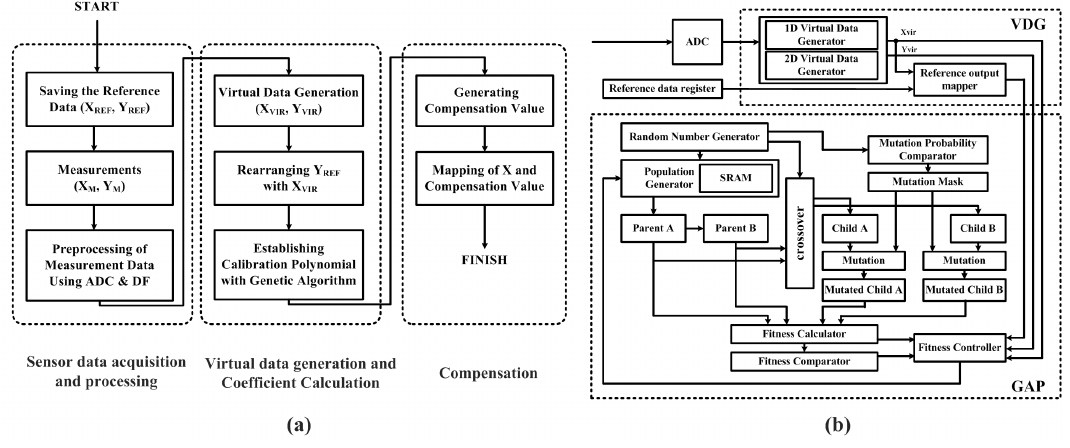
Figure 9. ( a ) Proposed sensor correction flow ( b ) Block diagram of sensor signal calibration Processor.